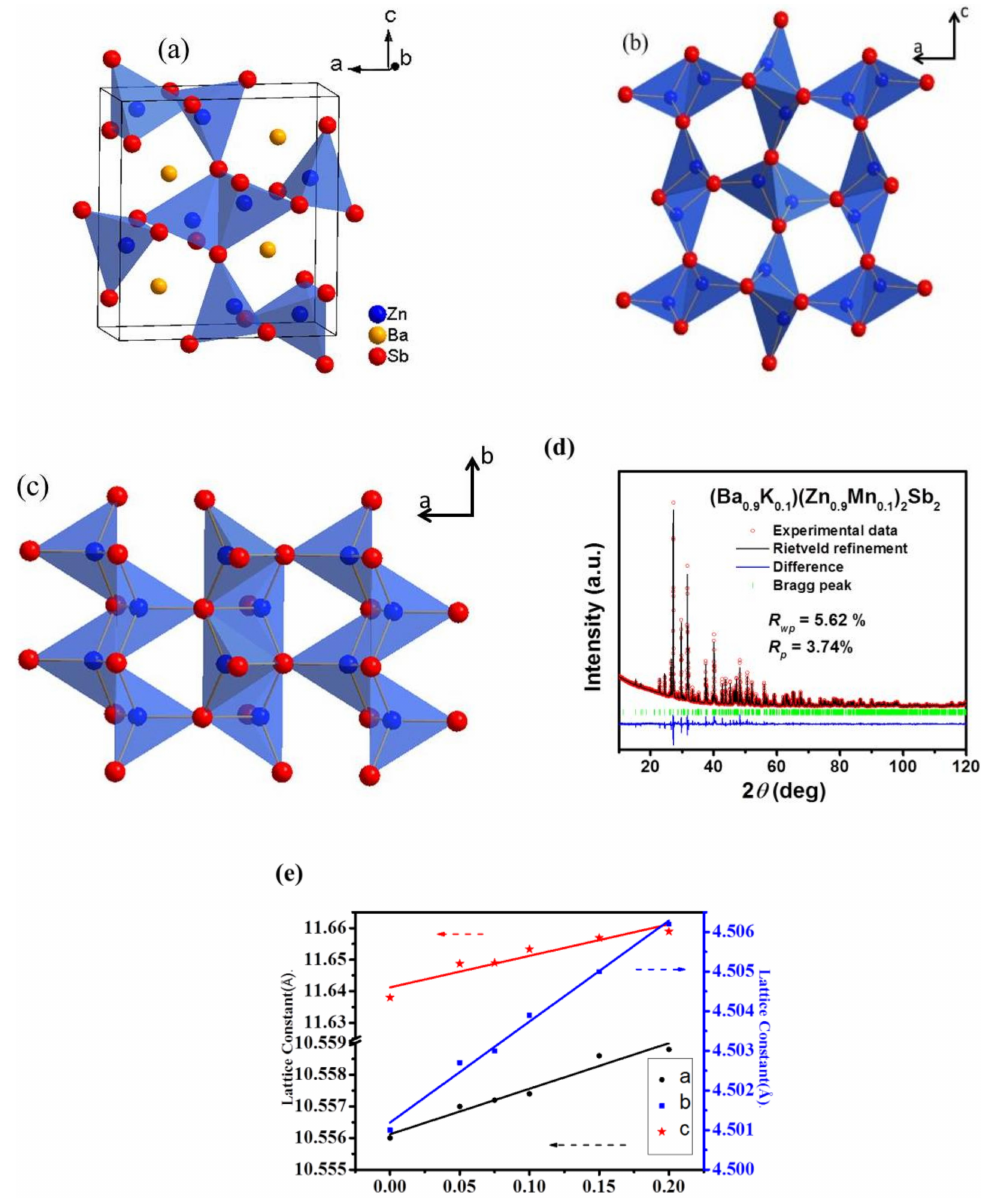
Figure 1. ( a ) Crystal structure of the parent phase, BaZn 2 Sb 2 ; ( b ) the sketch of the ZnSb framework in ac-plane; ( c ) the sketch of the ZnSb framework in the ab-plane; ( d ) the Rietveld refinement of (Ba 0.9 K 0.1 )(Zn 0.9 Mn 0.1 ) 2 Sb 2 ; ( e ) the change of the lattice constants, a (red dots), b (blue dots) and c (black dots), with Mn doping